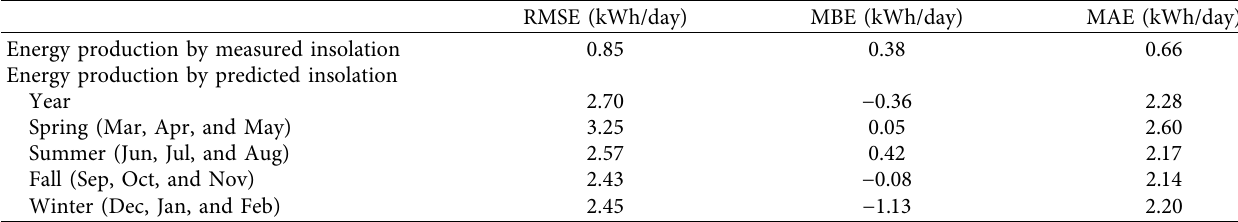
Table 10: Accuracies of the energy production estimations.